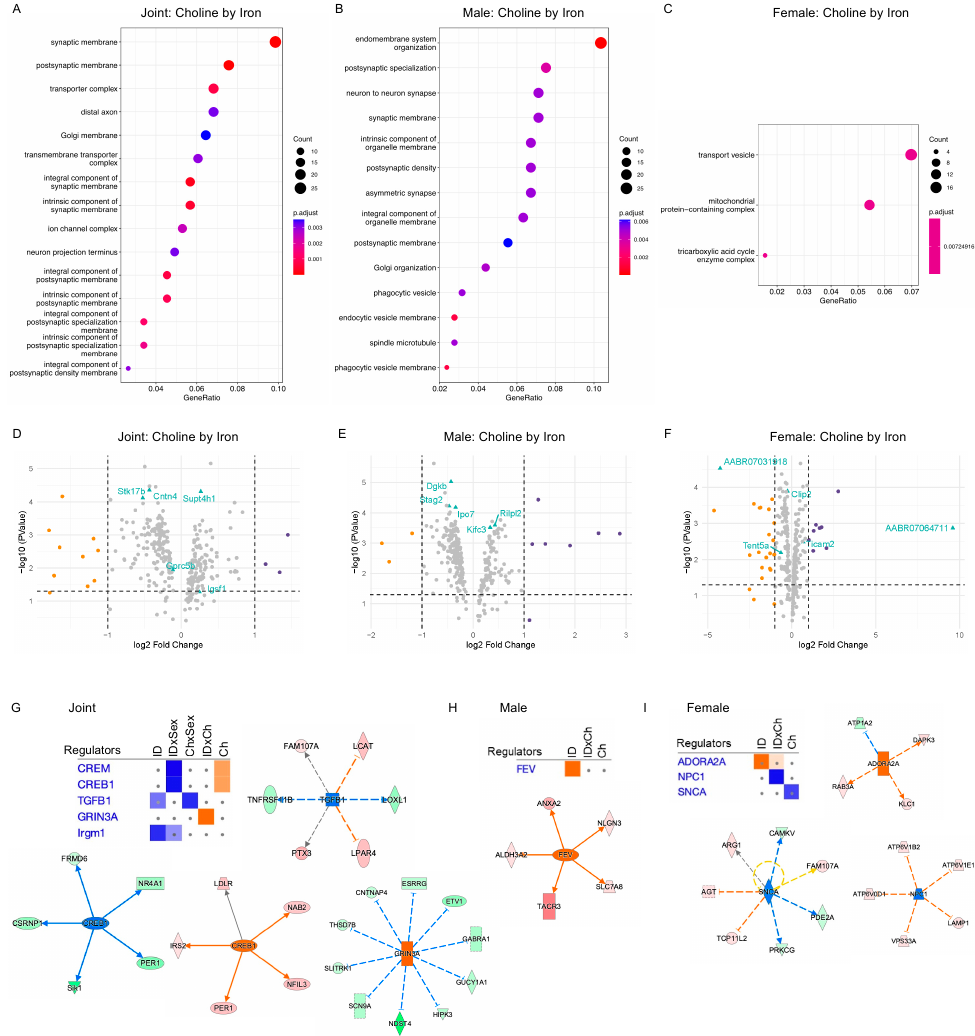
Figure 4. An alternative approach using top 300 VP outlier genes. ( A – C ) ORA analysis showing the effects of choline ‐ by ‐ iron interaction using sex ‐ combined ( A ), male ( B ), and female ( C ) datasets. ( D – F ) Volcano plots showing genes with significant p ‐ value (<0.05). ( G – I ) IPA ‐ predicted changes of upstream regulators in the hippocampus using sex ‐ combined ( G ), male ( H ), and female ( I ) datasets .